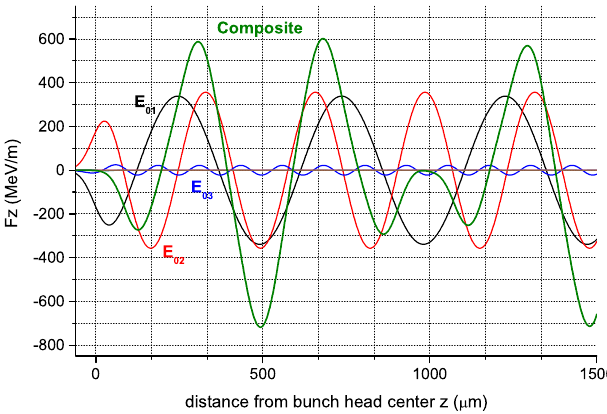
FIG. 4. (Color) Axial profiles of the longitudinal composite force and components of the force of the E a test electron along center of accelerating channel. The drive bunch moves from right to left and its center is located at z ¼ 0 .